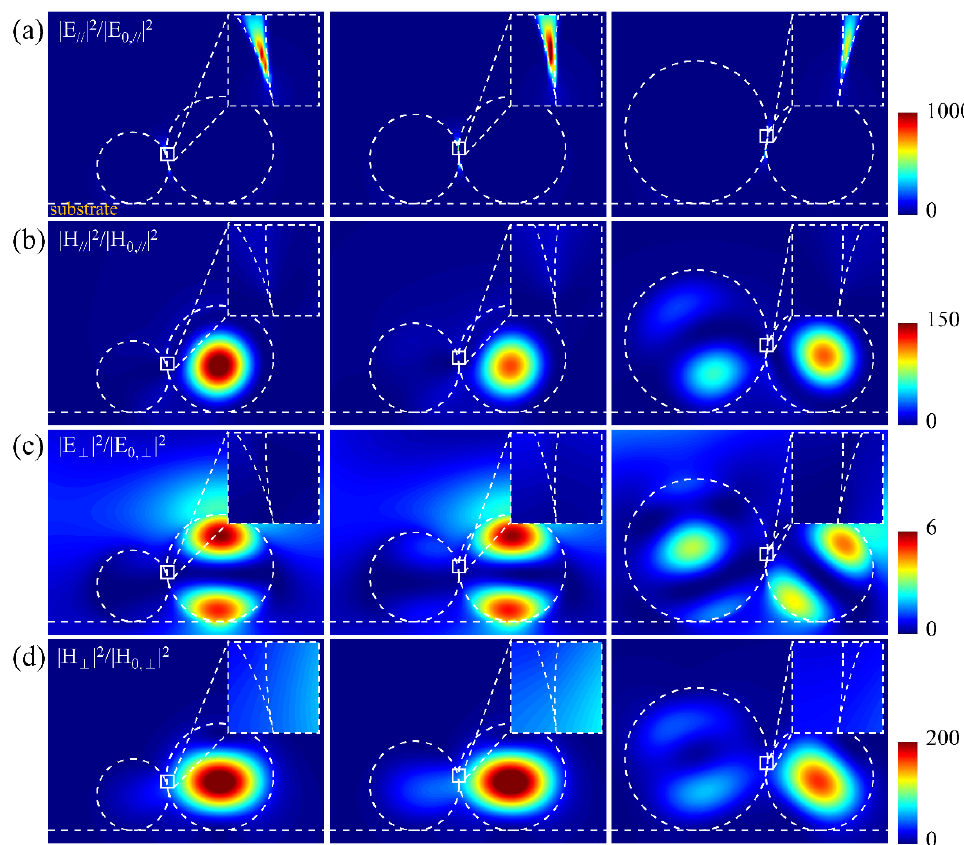
Figure 6. Simulated electric and magnetic field enhancement distributions of silicon dimers under ( a , b ) longitudinal and ( c , d ) transverse excitation at 532 nm.